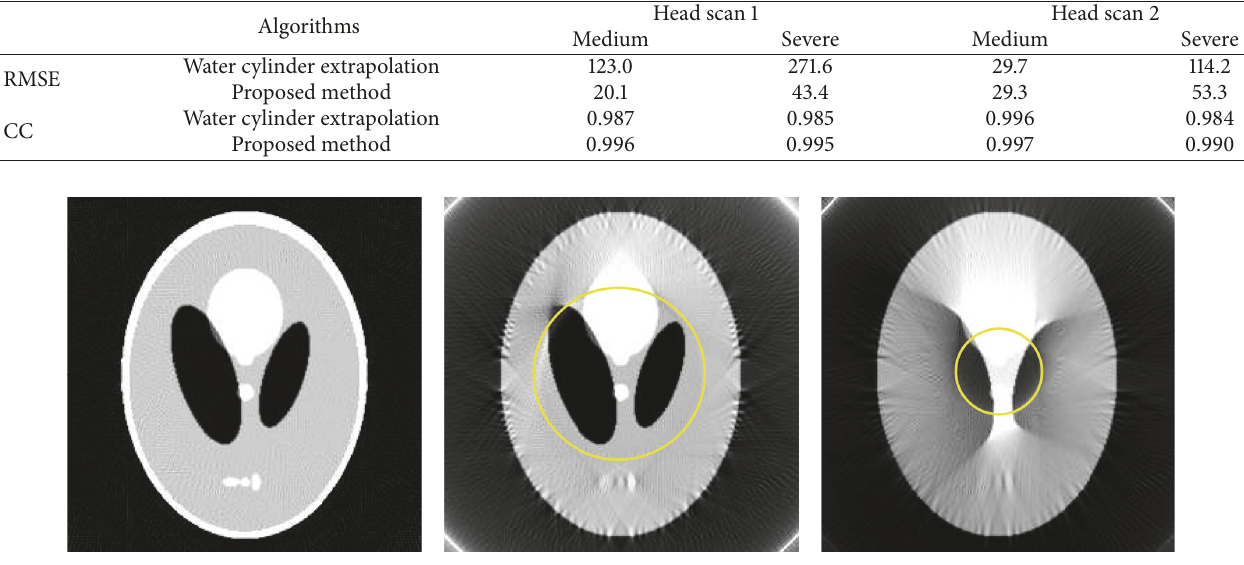
Figure 5: Reconstruction results of Shepp-Logan phantom using the proposed extrapolation method. From left to right: reference from nontruncated data, proposed correction method with medium truncation, and proposed correction method with severe truncation. The grayscale window is [0.1,0.2] . The yellow circles indicate the